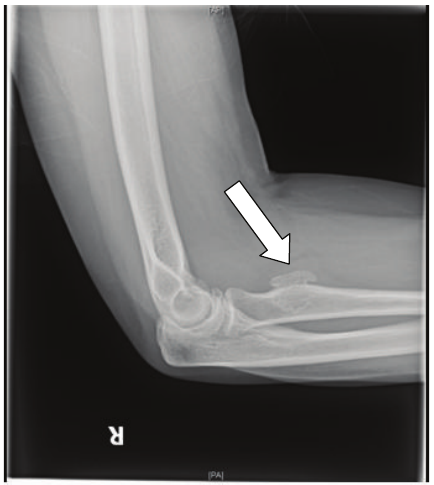
Figure 1: Plain radiograph reported this calcified area as an osteochondroma right forearm (fat